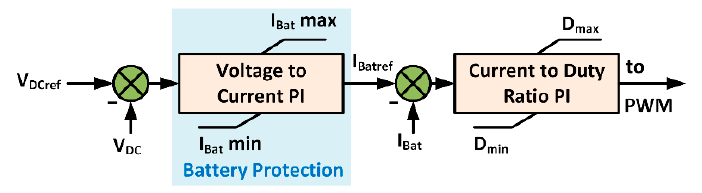
Figure 3. Battery DC–DC converter control with inner overcurrent protection.